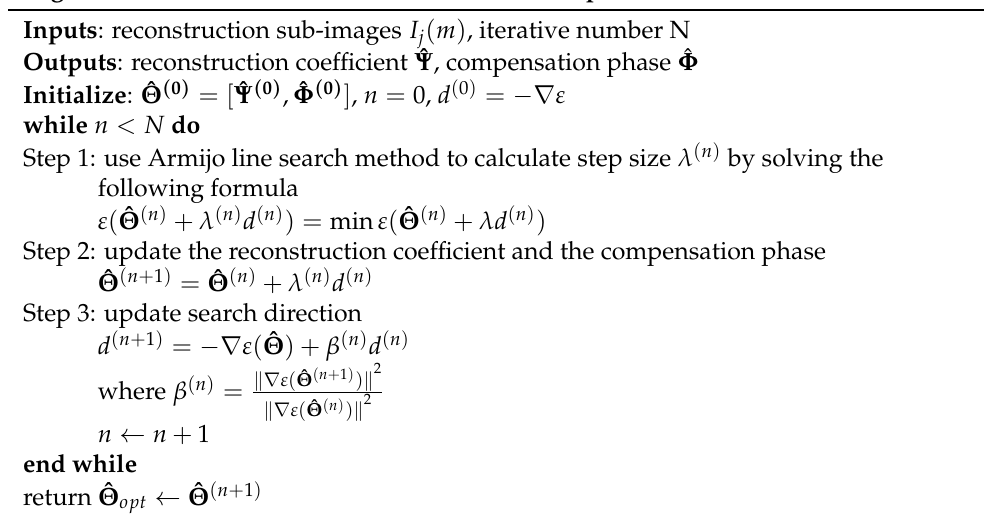
Algorithm 1. Reconstruction Coefficient and Compensation Phase